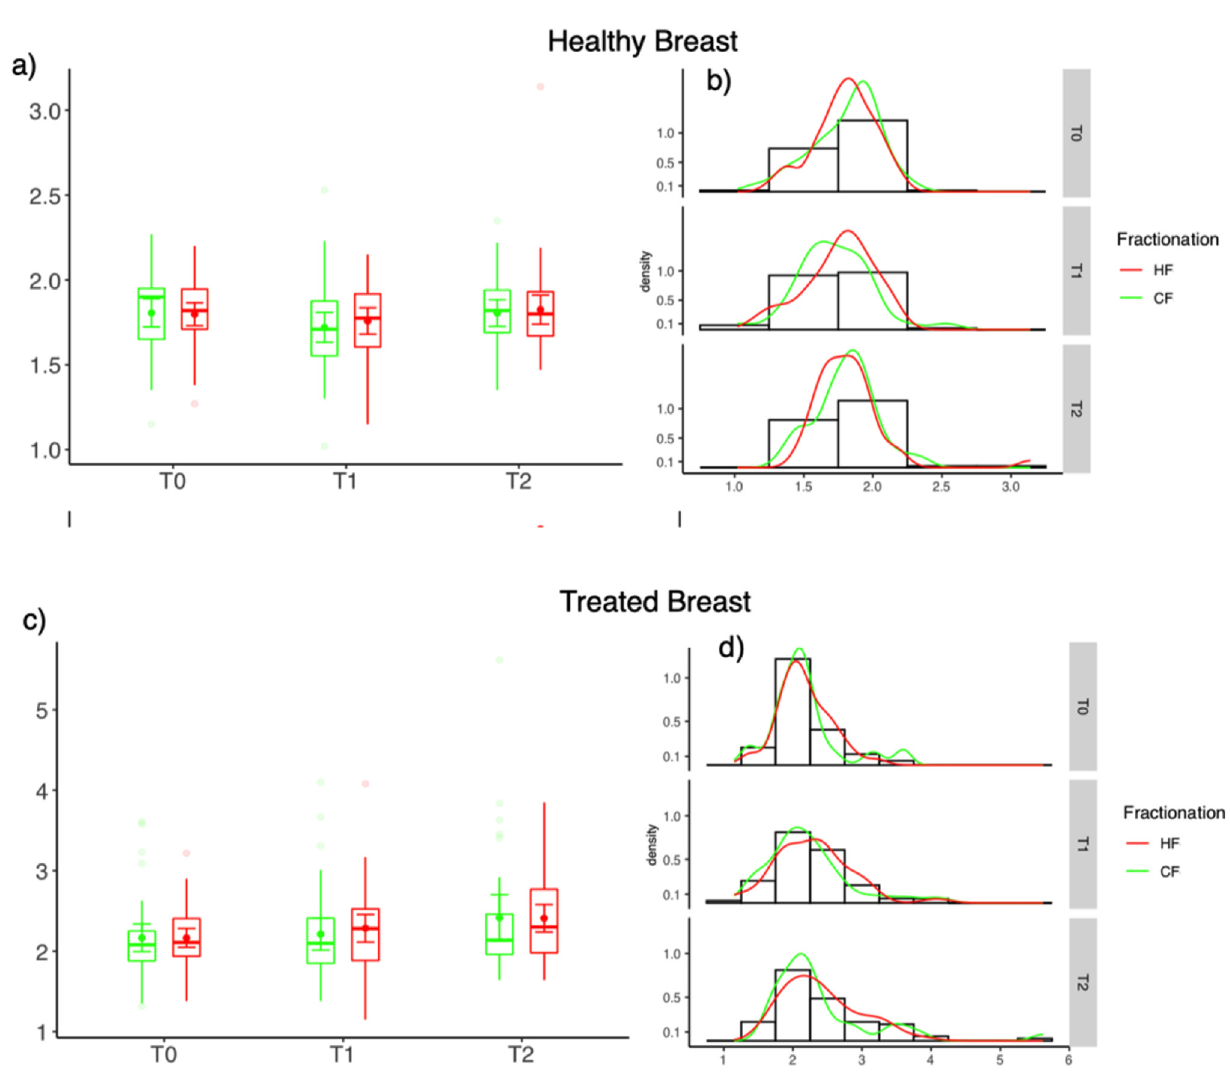
Figure 2. Differences of skin thickness between HF (red) and CF (green) at the end of radiotherapy (T1) and 6 weeks after the treatment (T2). Healthy breast ( a , b ) and treated breast ( c , d ); ( a , c ) Box-Plot diagrams and ( b , d ) distribution of values.